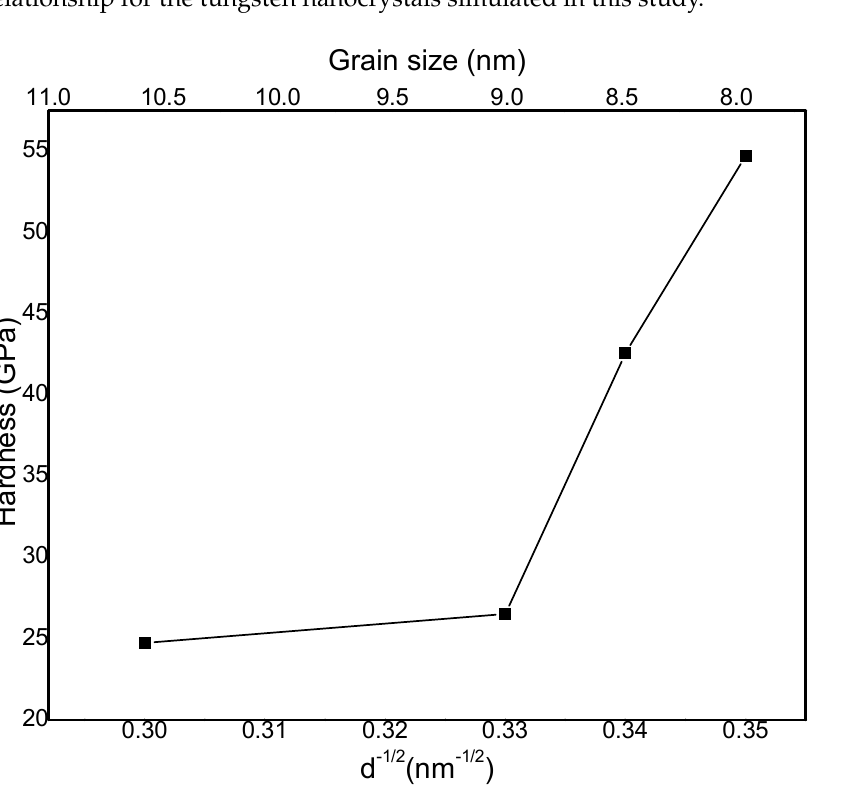
Figure 3. Size of grain vs. hardness in this MD study: Hall–Petch (HP) relationship for the nanocrys- talline W cases.